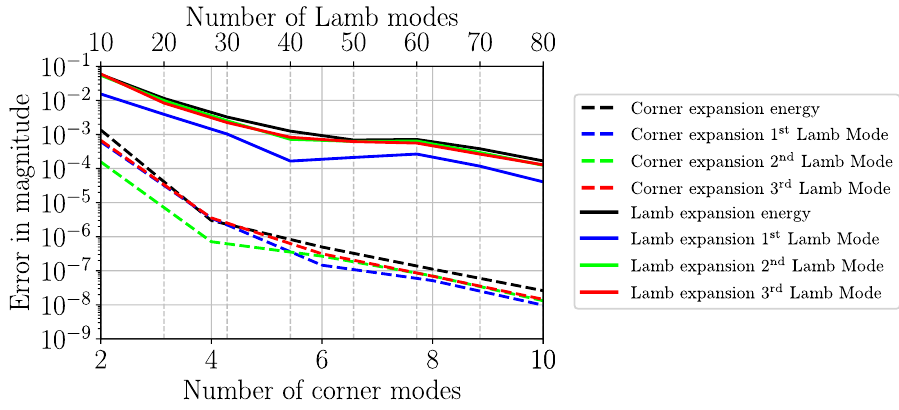
Figure 9. For k t = 8 and ν = 0.3 (the most challenging case of Figure 8), we illustrate the convergence of the energy and of the reflection coefficients of the three propagating modes. We display the absolute error between the computed reflection coefficients and a reference value, i.e., that obtained for N = 10 and M = 12, and the reference value for the energy is 1. The continuous lines correspond to the pure Lamb mode approach ( M = 0 ) as the number N of Lamb modes increases. The dashed lines correspond to our new approach for a fixed number N = 10 of Lamb modes as the number M of corner modes